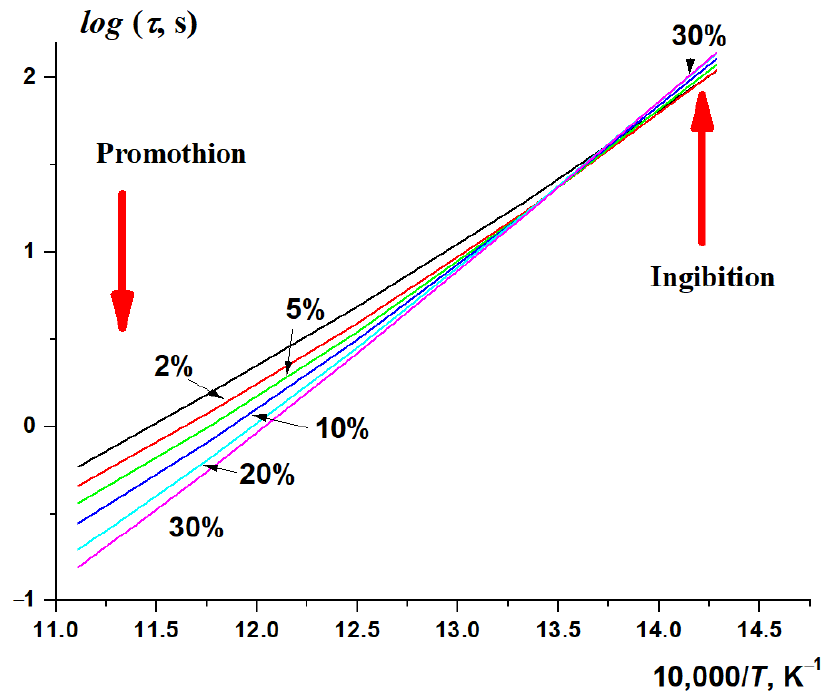
Figure 11. Calculated dependence of the autoignition delay time of stoichiometric CH 4 – H 2 – air mixtures on the initial temperature at different hydrogen concentrations (%); P 0 = 15 atm.